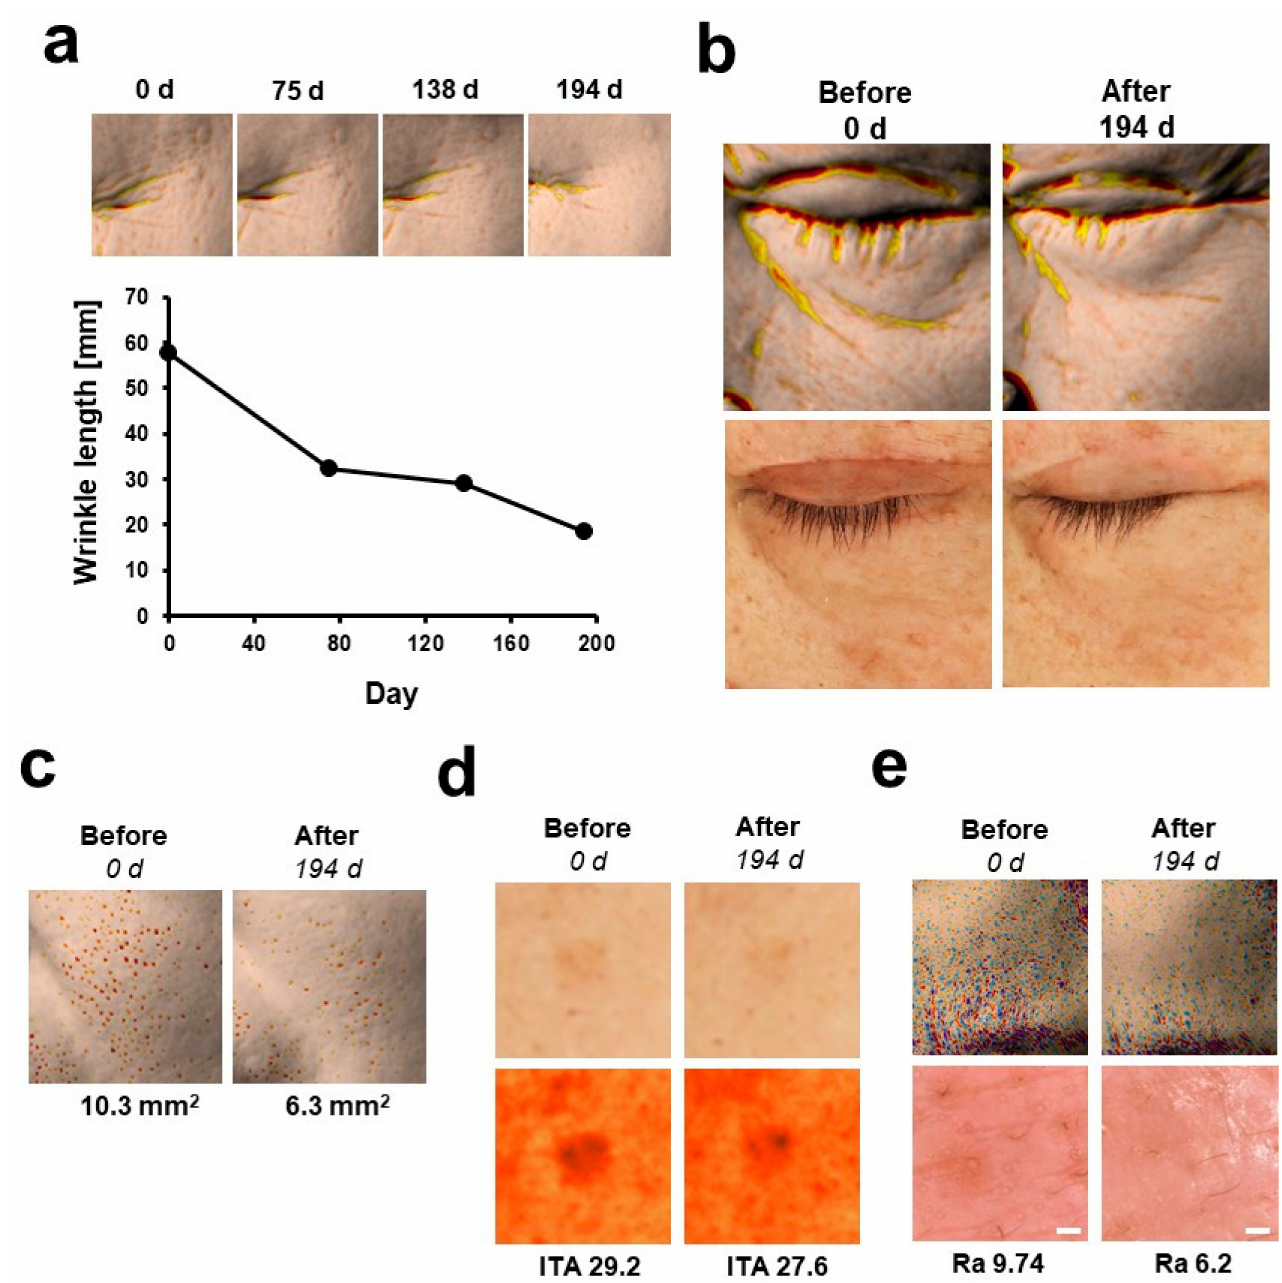
Figure 5. Long-term use of retinol and booster (194 days). Data for the most responsive human subject for each clinical features are shown. All data were analyzed by Antera 3D. ( a ) Improve- ment in the appearance of crow’s feet. ( b ) Improvement in the appearance of frontal eye wrinkle. ( c ) Improvement in the appearance of pores (front cheek area). ( d ) Improvement in hyperpigmenta- tion spots. ( e ) Improvement in skin texture. Skin surface (lower row) was evaluated by microscopy. Scale bar (white), 200 µ